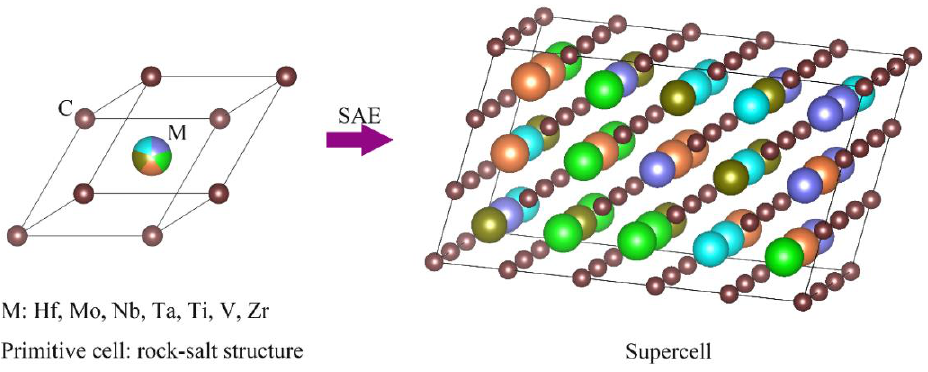
Figure 1. The similar atomic environment supercell containing 90 atoms for HEC, enlarged by the 3 × 3 × 5 primitive rock-salt structure.